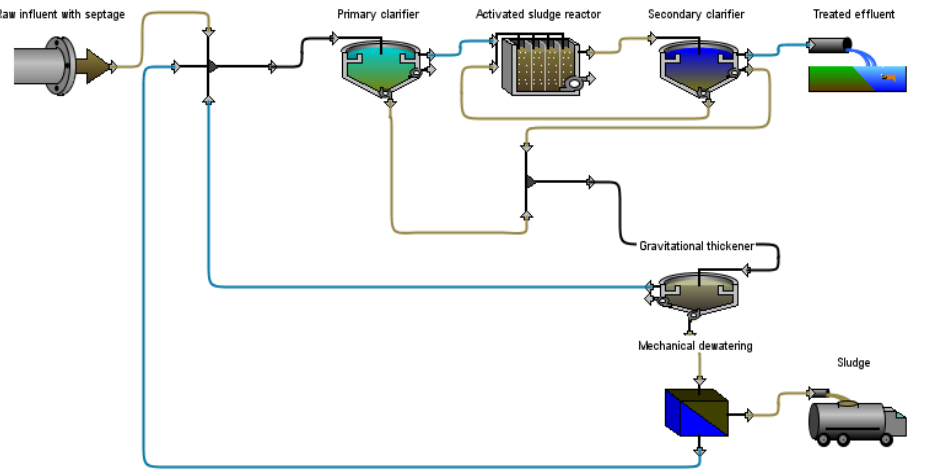
Figure 2. Layout of the sewage treatment